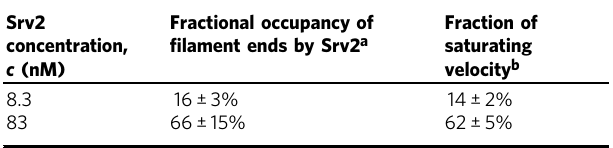
Table 1 Comparison of fi lament end occupancy by Srv2 and depolymerization rate.